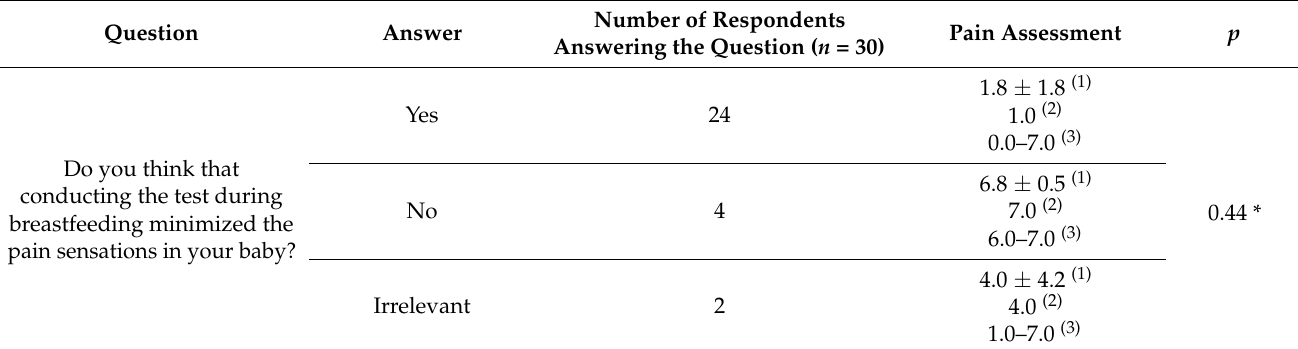
Table 6. The relationship between pain assessment and the answer to question no.